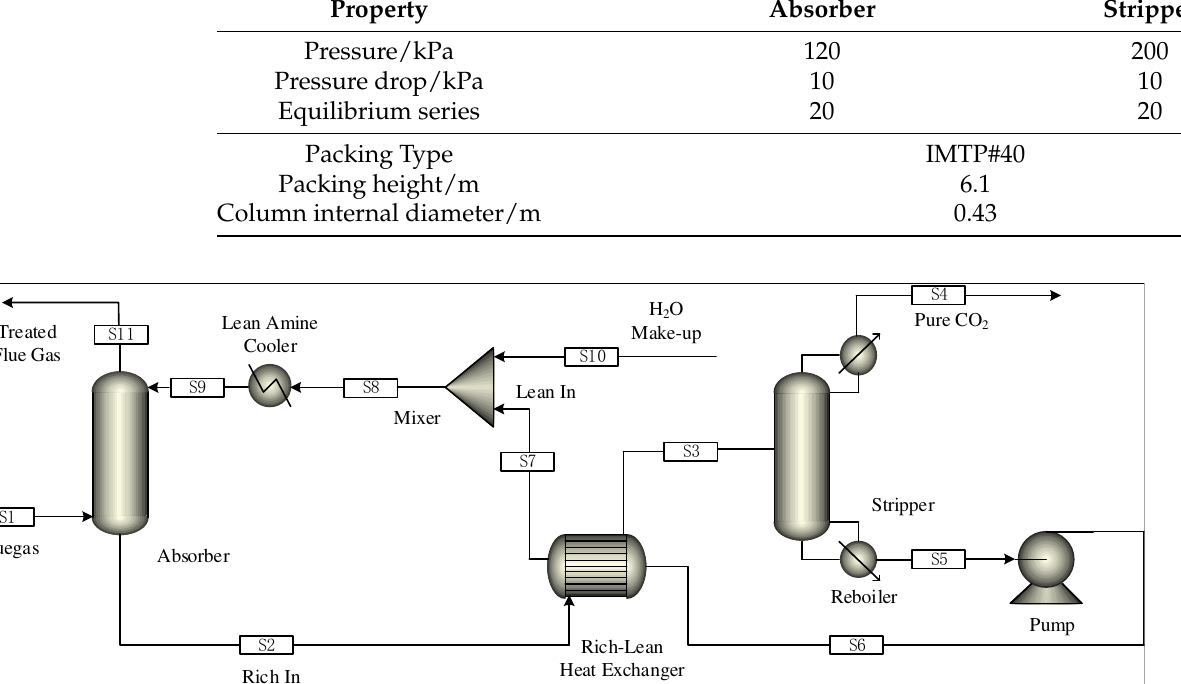
Figure 3. Steady-state model of carbon capture system in Aspen